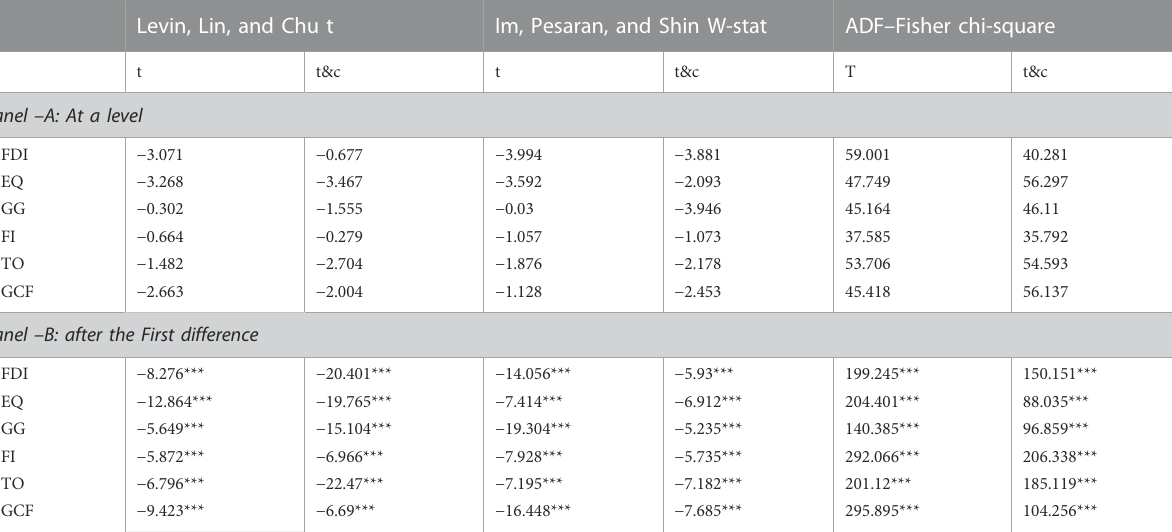
TABLE 3 First-generation panel unit root test.